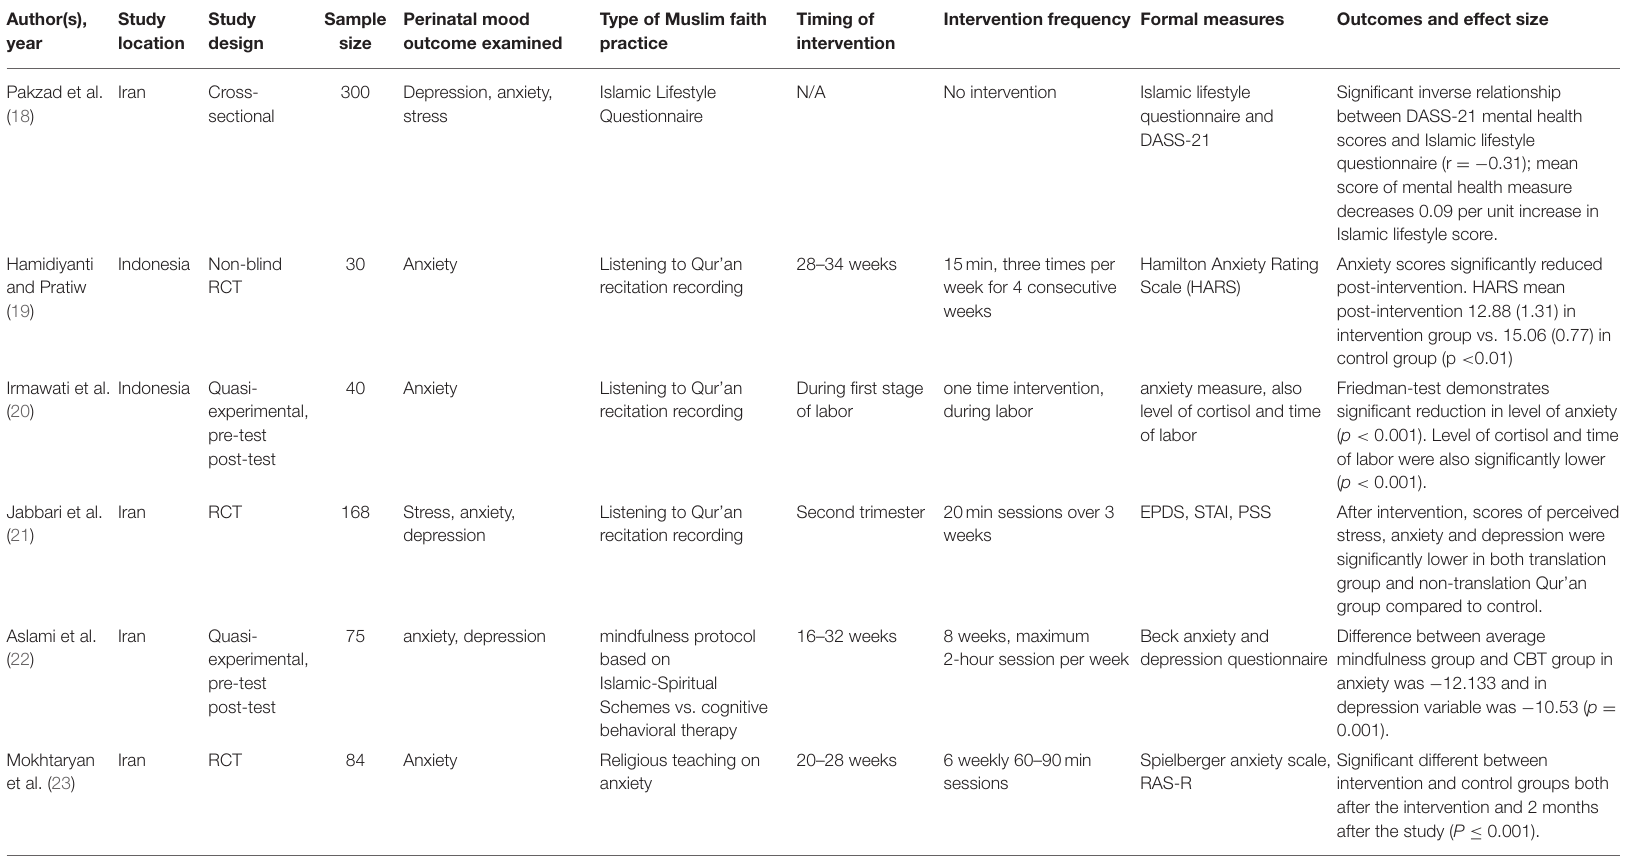
TABLE 1 | Characteristics of quantitative